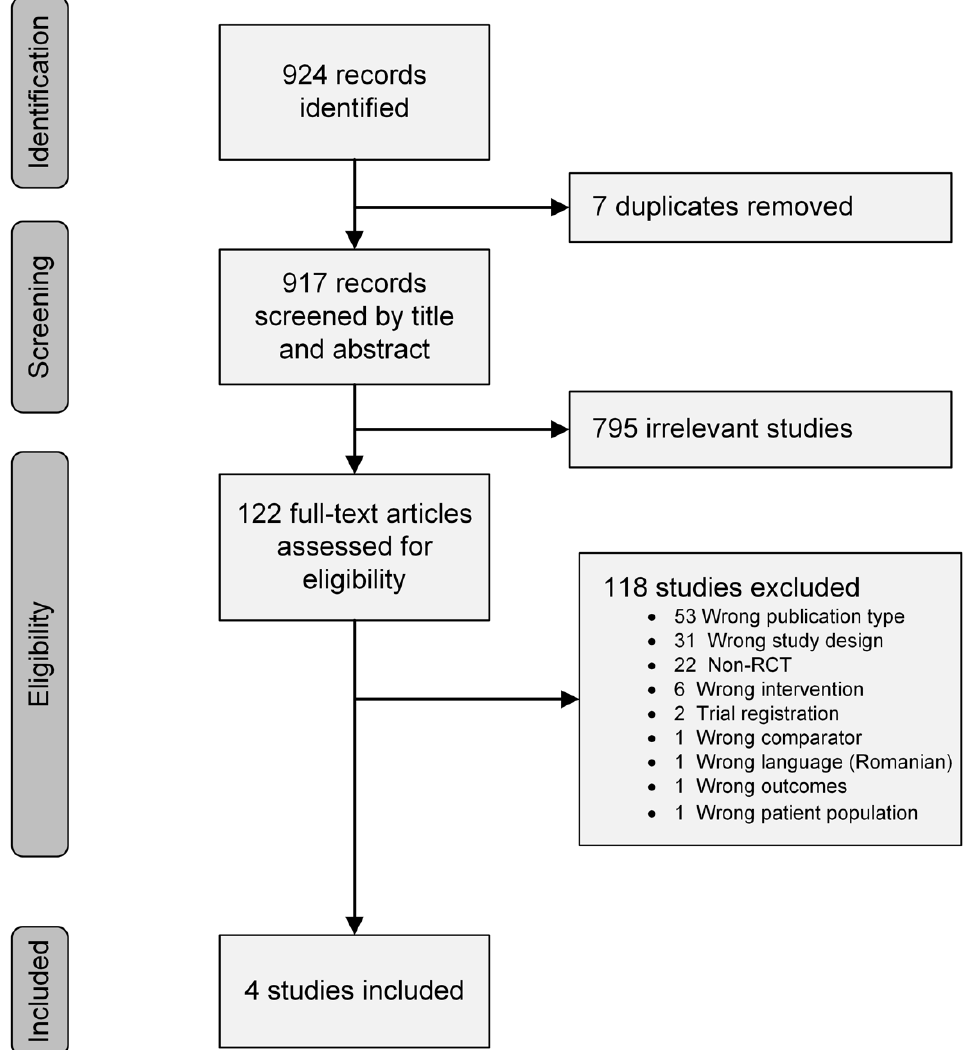
Figure 1. PRISMA flow diagram of the selection process and study search results.